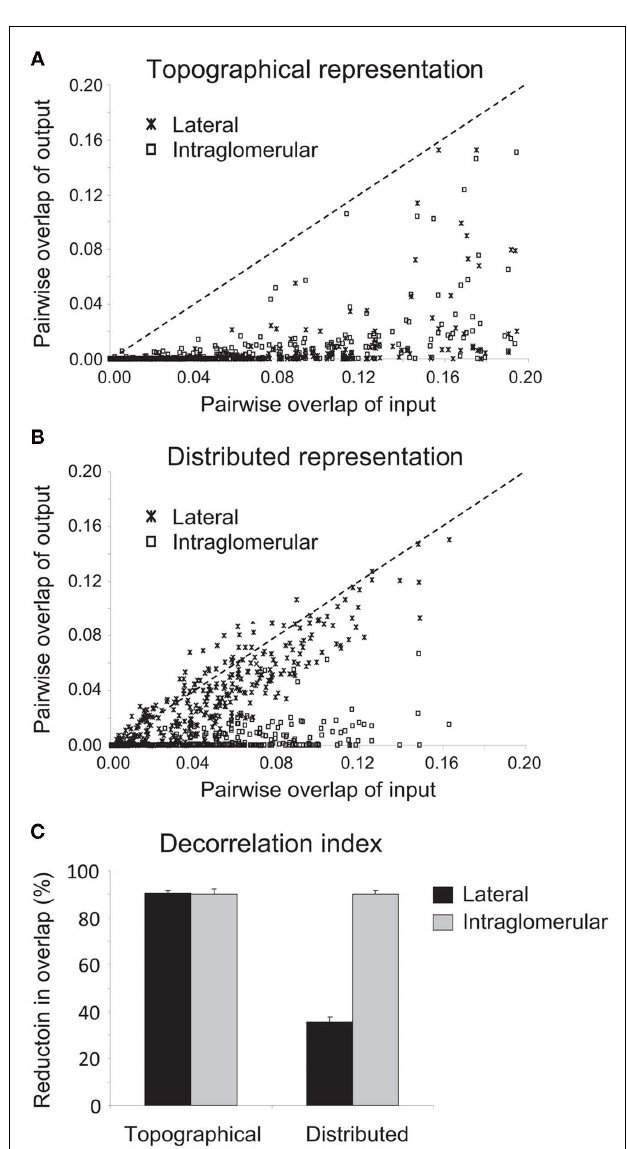
FIGURE 3 | Quantification of the efficacy of decorrelation mechanisms on different representation scenarios. (A) Efficacy of lateral and intraglomerular decorrelation mechanisms on topographical representations. Sixty simulations for each mechanism were run using randomized model odorant pairs with differing degrees of similarity.The overlap between each of these paired odorants prior to the application of inhibition (corresponding to Figures 2A,B ) was then plotted against their overlap following lateral or intraglomerular inhibition (corresponding to Figures 2C,E , respectively). Points lying substantially below the diagonal signify effective decorrelation of the representations of those odorant pairs; points lying along the abscissa signify representations decorrelated to the extent that they no longer overlap at all. Both lateral and intraglomerular inhibition mechanisms effectively decorrelated topographical representations. (B) Efficacy of lateral and intraglomerular decorrelation mechanisms on distributed representations. Sixty simulations for each mechanism were run using randomized model odorant pairs with differing degrees of similarity.The overlap between each of these paired odorants prior to the application of inhibition (corresponding to Figures 2A,B )